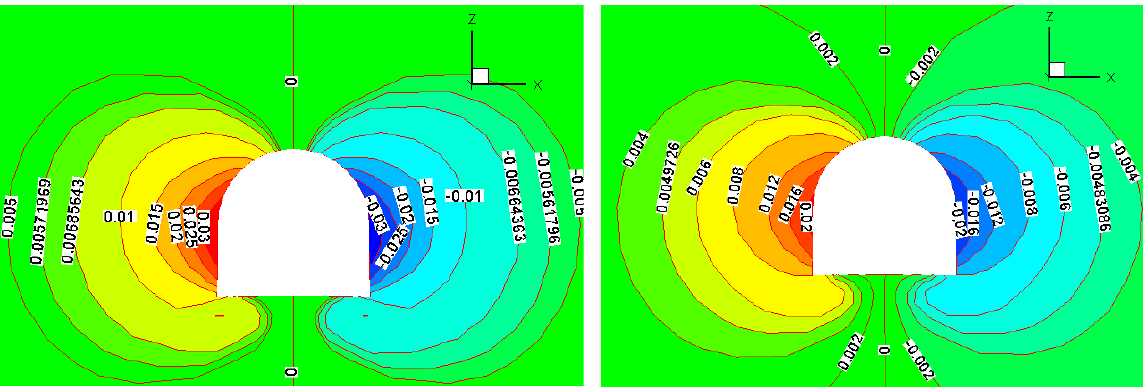
Figure 13. Two sides displacement contour of the test roadway at an excavation depth of 12 m.